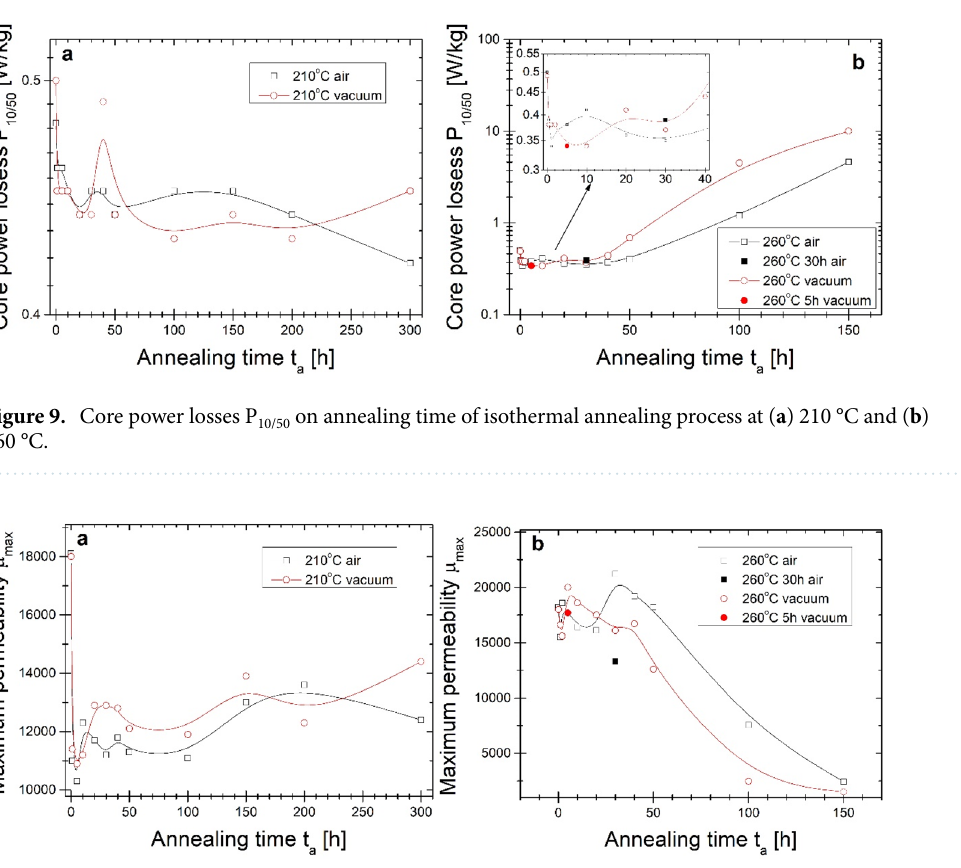
Figure 10. Maximum magnetic permeability on the annealing time of the isothermal process at ( a ) 210 °C and ( b ) 260